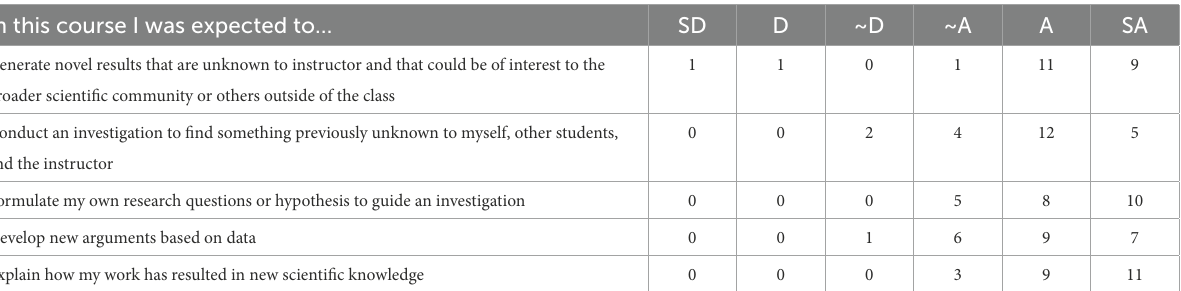
TABLE 3 LCAS survey discovery/research